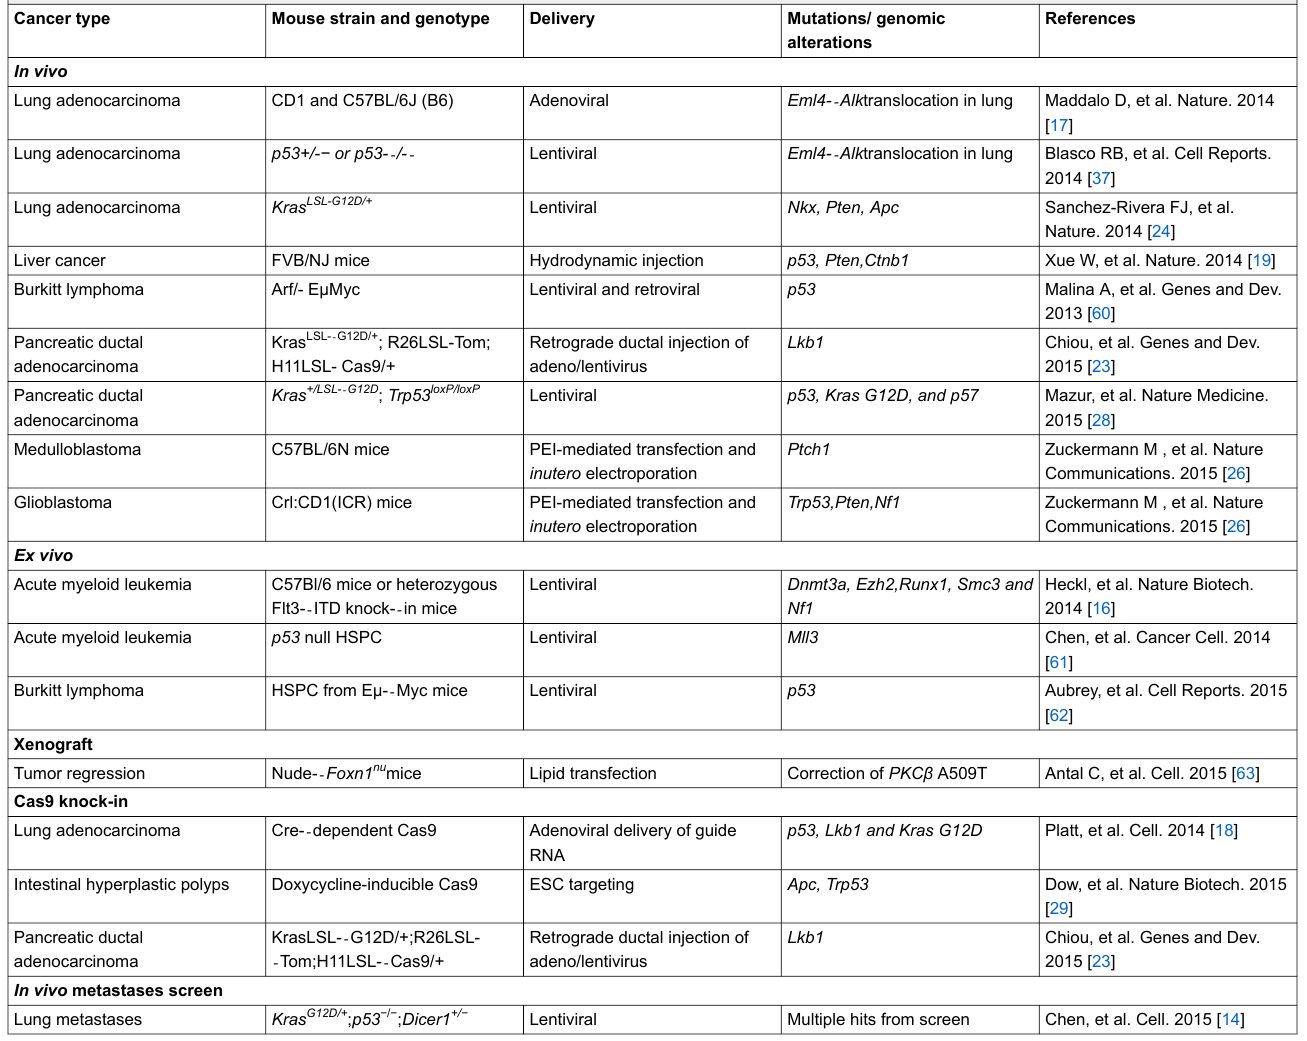
Table 1: Cancer mouse models developed by CRISPR–Cas9 based genome editing Cancer